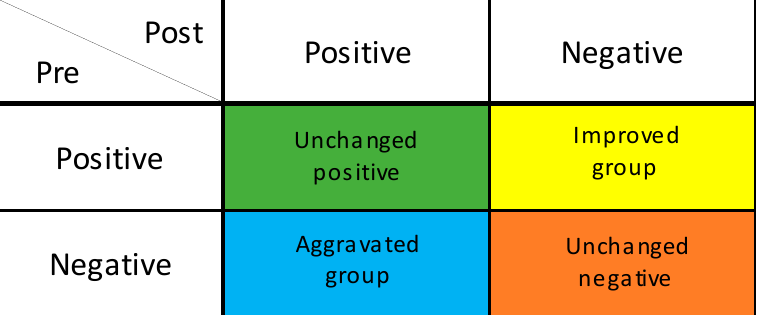
Figure 1. Degree of improvement in periodontal condition. GUM bleeding test; Improved group: Positive to Negative; Unchanged positive group: Positive to Positive; Unchanged negative group: Negative to Negative. Aggravated group: Negative to Positive.